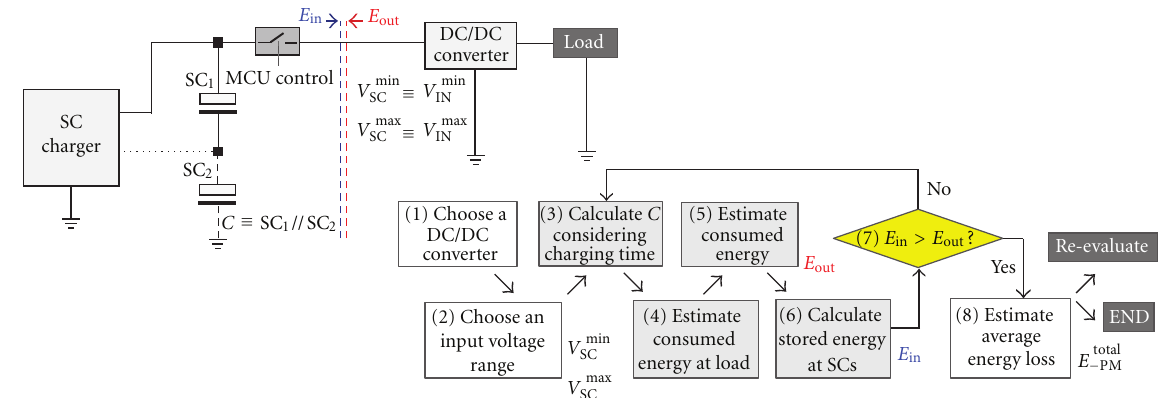
Figure 6: Strategy for the power-matching circuitry